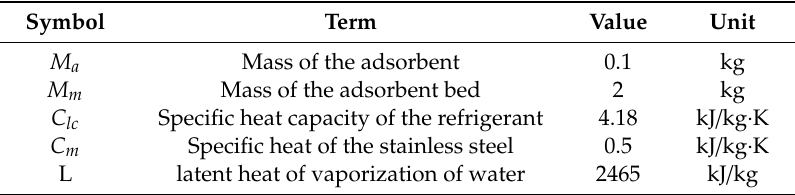
Table 7. Physical property parameters used in the simulation. Symbol Term